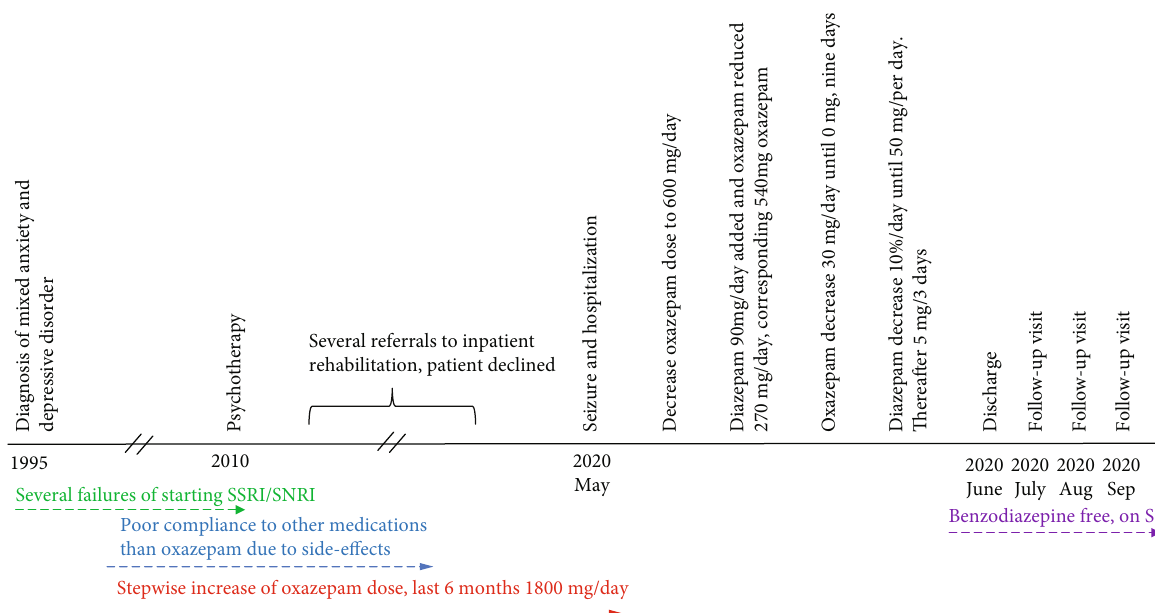
Figure 1: Clinical course of the